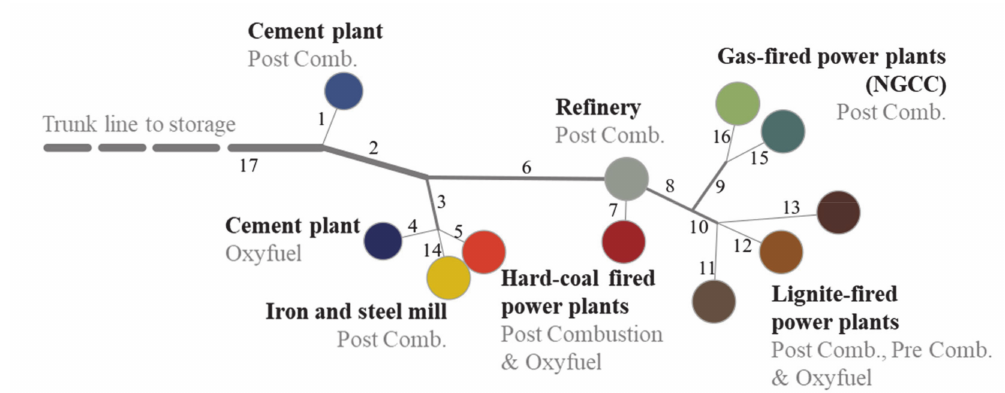
Figure 1. Schematic representation of the transport network (dimensions not to scale). The regional cluster of the 11 CO 2 emitters is 75 km in diameter, while the trunk pipeline has a length of 300 km in its onshore part. Numbers on the pipeline segments are identifiers for further